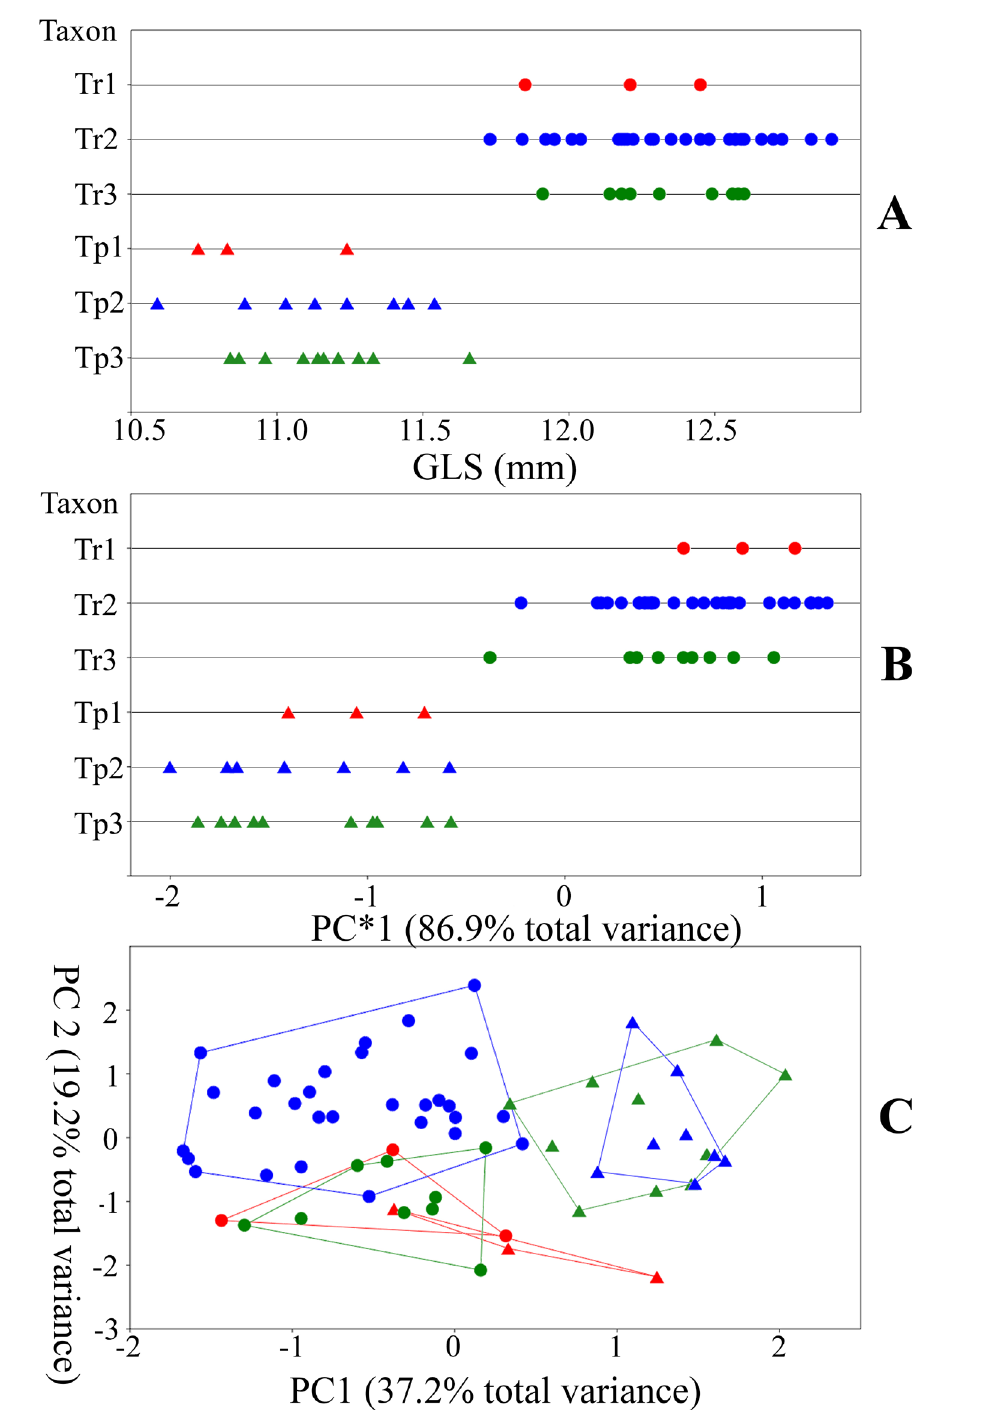
Fig. 4. Scatter plots obtained from morphological analyses of Tylonycteris spp. A . Range of GLS measurements of specimens within each group of Tylonycteris spp. B . Range of PC*1 scores of specimens of Tylonycteris spp. obtained from PCA of log-transformed raw data of craniodental measurements. C . Plot of PC 1 against PC 2 obtained from PCA on log-transformed standardized data. Triangles and circles refer to T. pachypus s. lat. and T. robustula s. lat., respectively. Colour patterns indicate the mtDNA haplogroups: green for Tp3 and Tr3 (northern Indochina); blue for Tp2 and Tr2 (other regions of the Southeast Asian mainland); red for Tp1 and Tr1